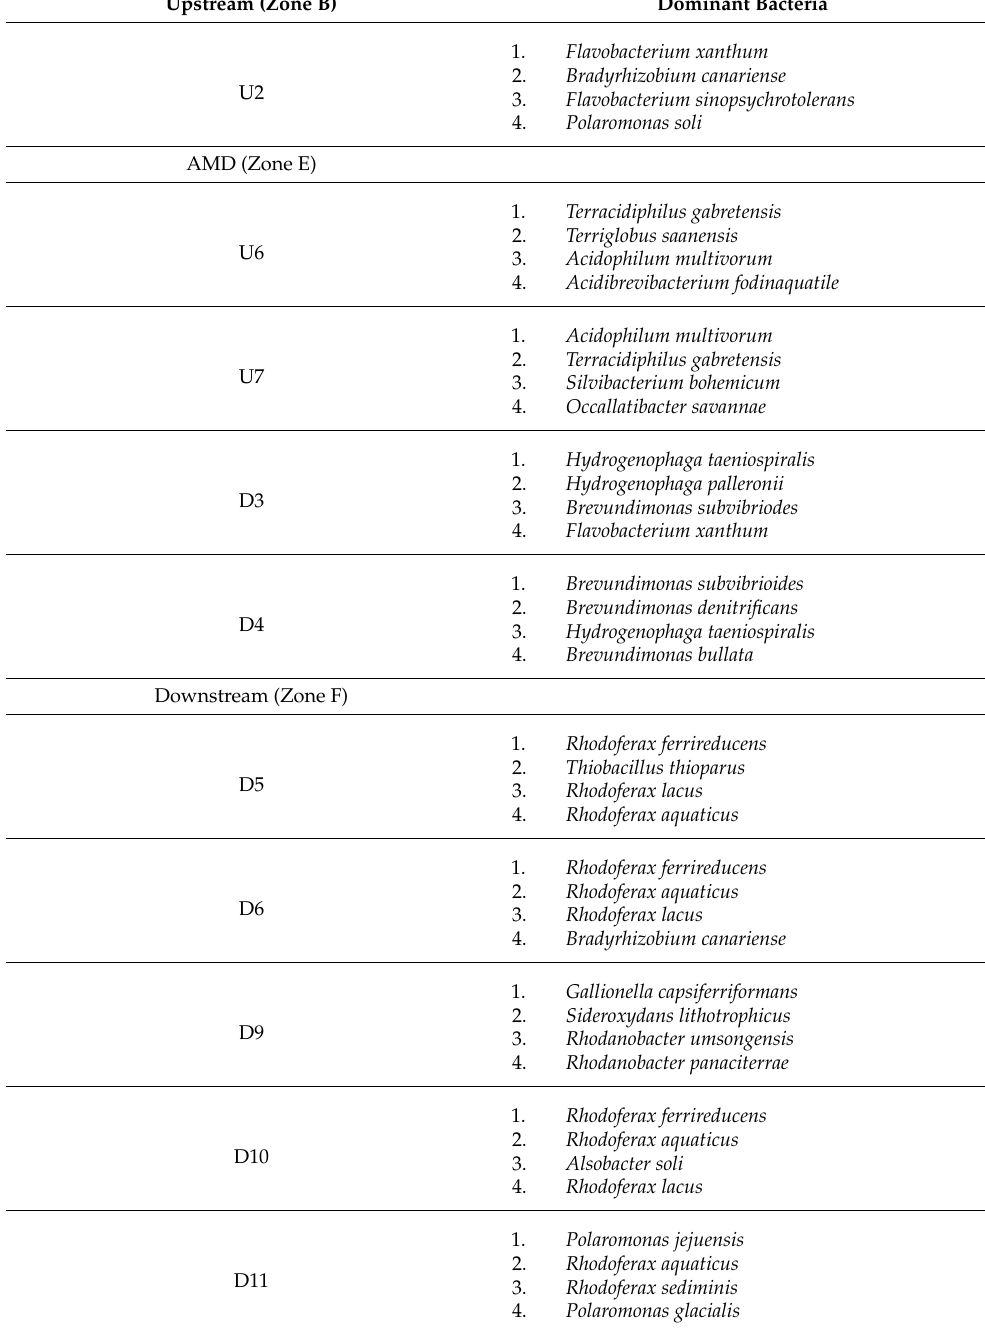
Table 5. Site specific bacterial distribution in order of the frequency of occurrence (at the species